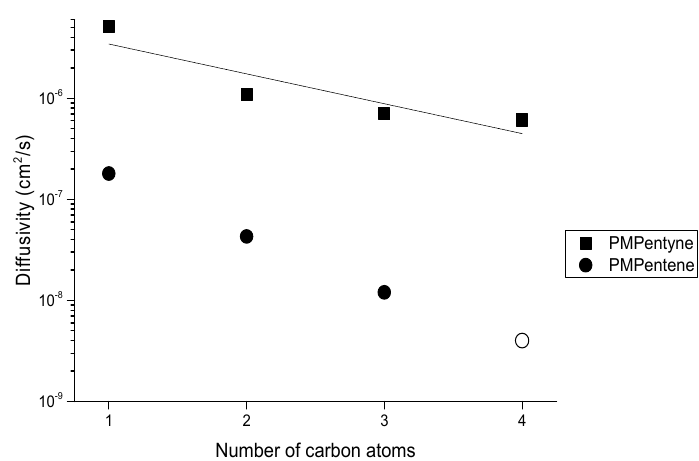
Figure 7. Di ff usion coe ffi cients of PMPentyne and PMPentene at 25 ◦ C: (cid:4) data calculated from D = P / S , Figure 7. Diffusion coefficients of PMPentyne and PMPentene at 25 °C: data calculated from • experimental data; calculated using correlation approach (Equations (7)–(9)). D = P / S , experimental data; calculated using correlation approach (Equations (7)–(9)). (cid:35)